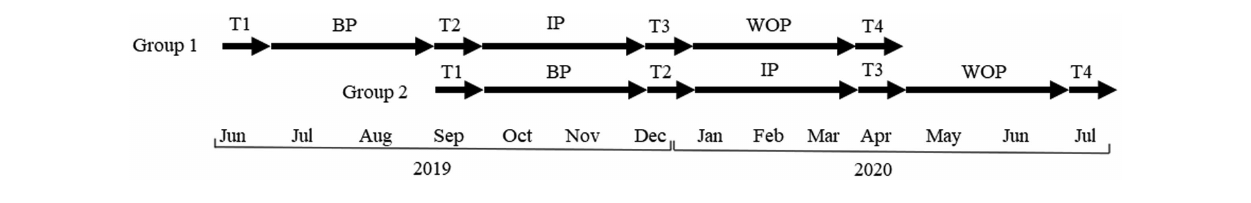
FIGURE 1 | Research timetable. T1–T4 represent the evaluations meeting occurred with 3 months apart. BP, Baseline Phase; IP, Intervention Phase; and WOP, Wash-Out